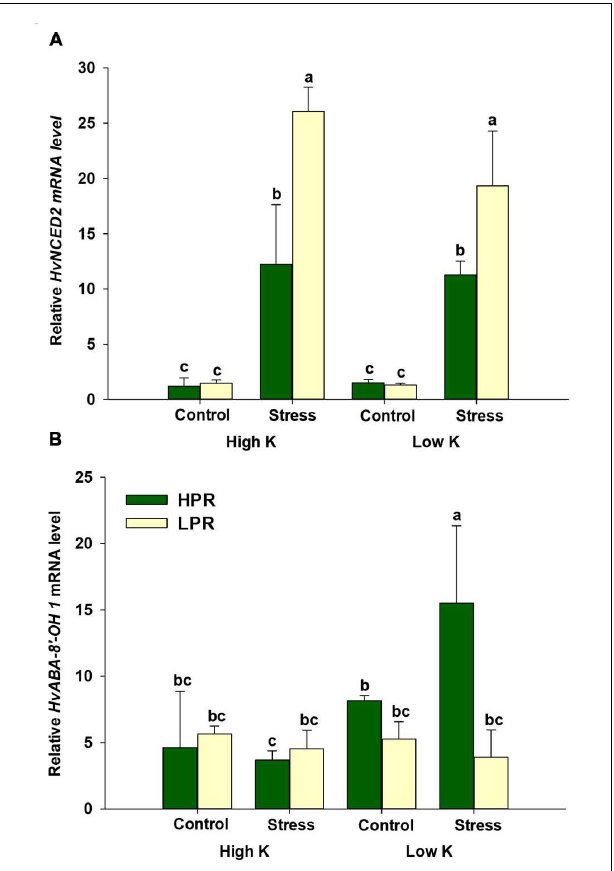
FIGURE 5 | Influence of K supply on the expression of genes involved in ABA biosynthesis and degradation in flag leaves of barley under drought stress. Relative mRNA levels of (A) 9- cis - epoxy-carotenoid dioxygenase ( HvNCED2 ) and (B) ABA-8 (cid:48) -hydroxylase 1 ( HvABA-8 (cid:48) -OH1 ) in flag leaves of the lines HPR and LPR. Plants were pre-cultured under sufficient water supply (control) or water limitation (stress) and under low or high K supply. Flag leaves from 12 weeks-old plants were harvested 12 days after imposing drought stress. Bars indicate mean ± SD. Different letters denote significant differences according to three-way ANOVA and Tukey’s test ( p < 0.05; n = 4–6). Ubi E2-17 (ubiquitin-conjugating enzyme) was used as reference